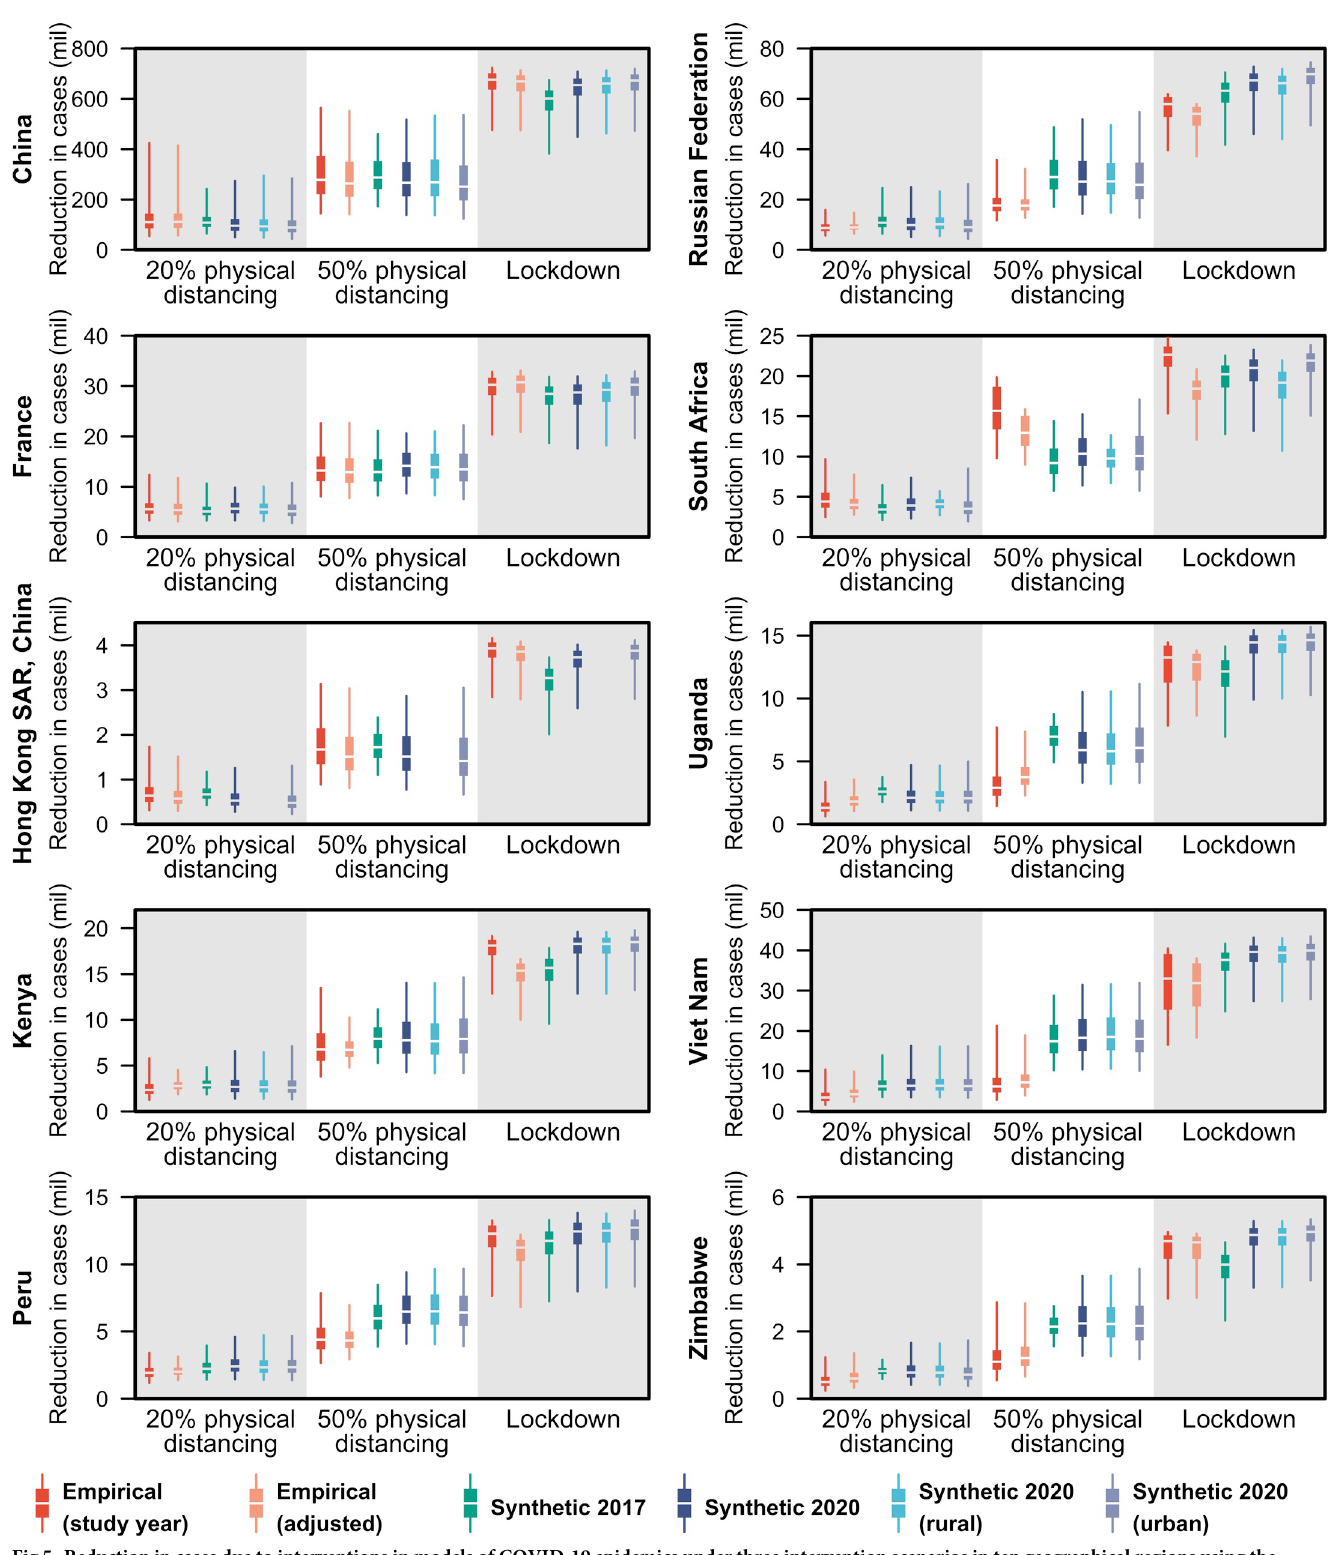
PLOS Computational Biology | https://doi.org/10.1371/journal.pcbi.1009098 July 26,